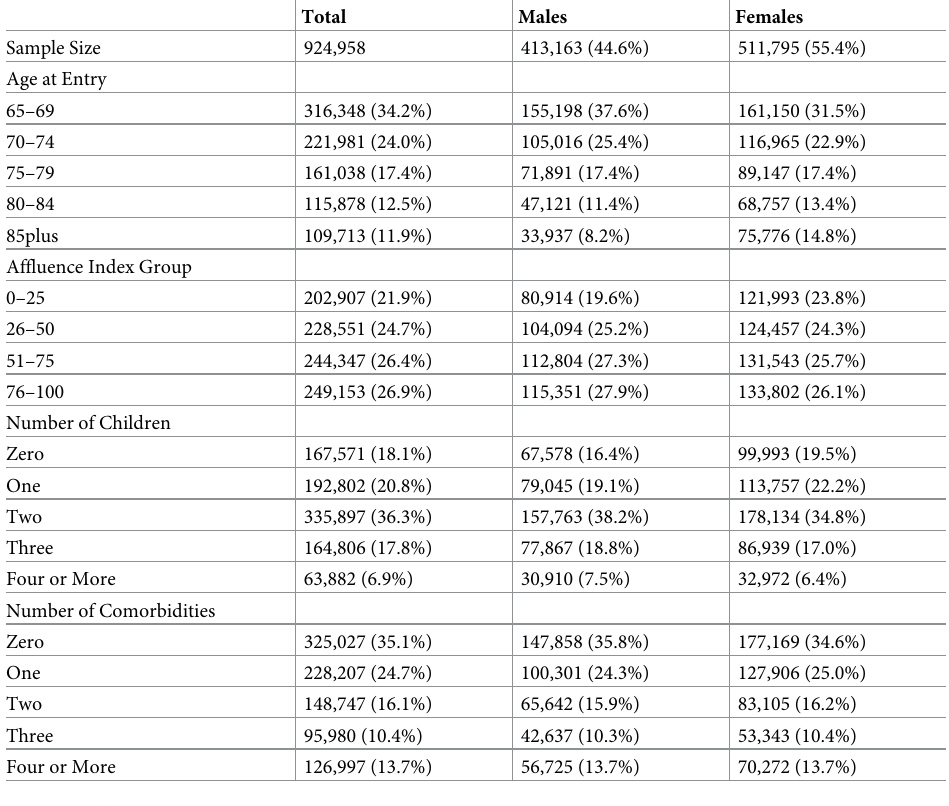
Table 1. Distribution of socio-demographic variables in the study sample at